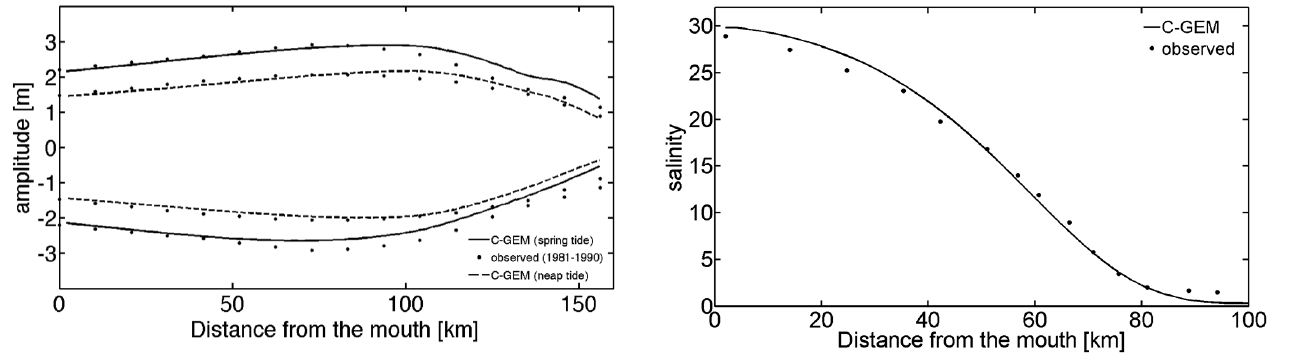
Figure 8. Comparison between salinity measurements (Regnier et al., 1998) and simulated longitudinal distribution of the tidally av- eraged salinity for a mean tidal amplitude of 3.7m, modeled using a constant freshwater discharge Q = 39m 3 s − 1